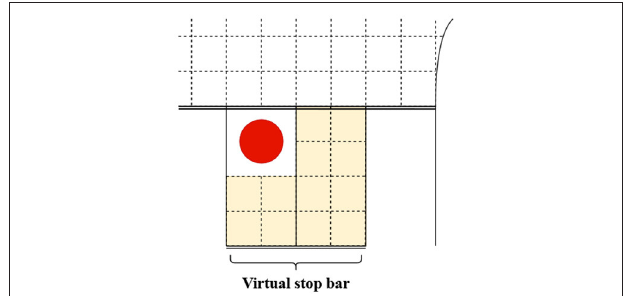
FIGURE 2 | The extended area whenever obstacle is positioned at the exit of the lane. The circle represents the obstacle, and the highlighted area is where the grid is extended.